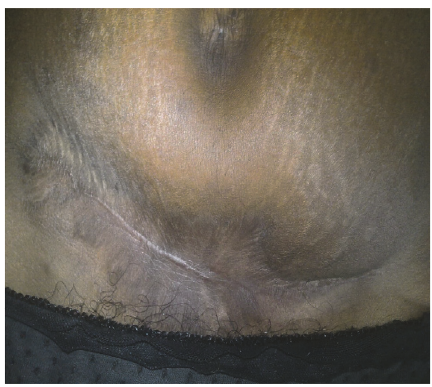
Figure 5: Completely healed anterior abdominal wall with appre- ciable